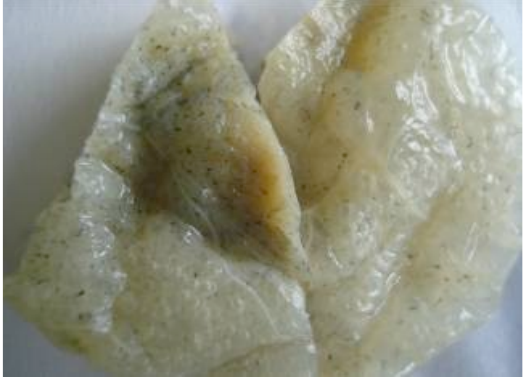
Image 4. Lung of Indian Lion showing pale and clumps of black coloration all over the parenchyma